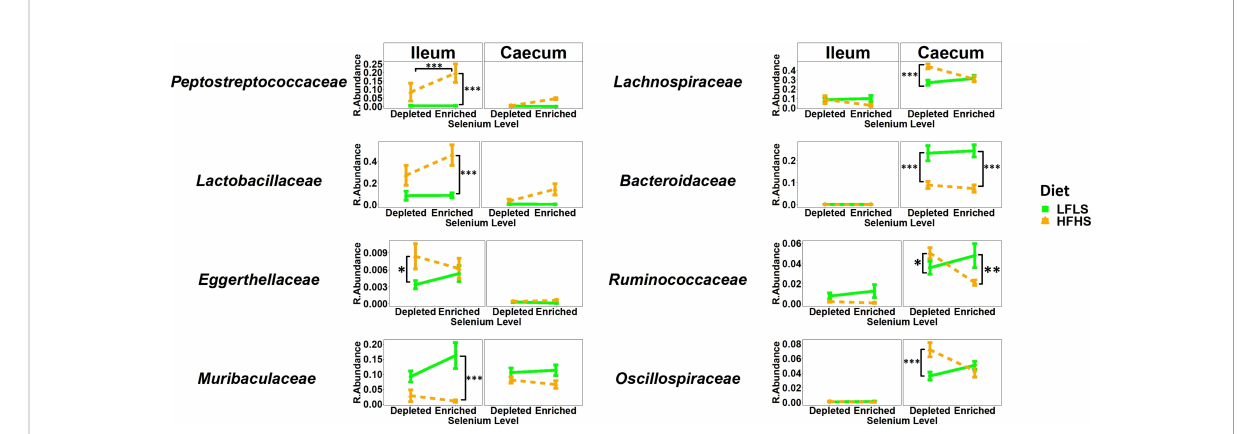
FIGURE 6 Relative bacterial abundance at the family rank in response to Se-enriched and Se-depleted LFLS or HFHS diets in the intestinal segments ileum and caecum. Data are expressed as the mean ± SEM (n=12). P values of linear contrast analysis are detailed when signi fi cant ‘ *** ’ P < 0.001, ‘ ** ’ , P < 0.01, ‘ * ’ , P<0.05 using contrast test between enriched and depleted Se levels, LFLS and HFHS formulations and the combination between Se levels and formulations. The samples were analysed at day 28 of the